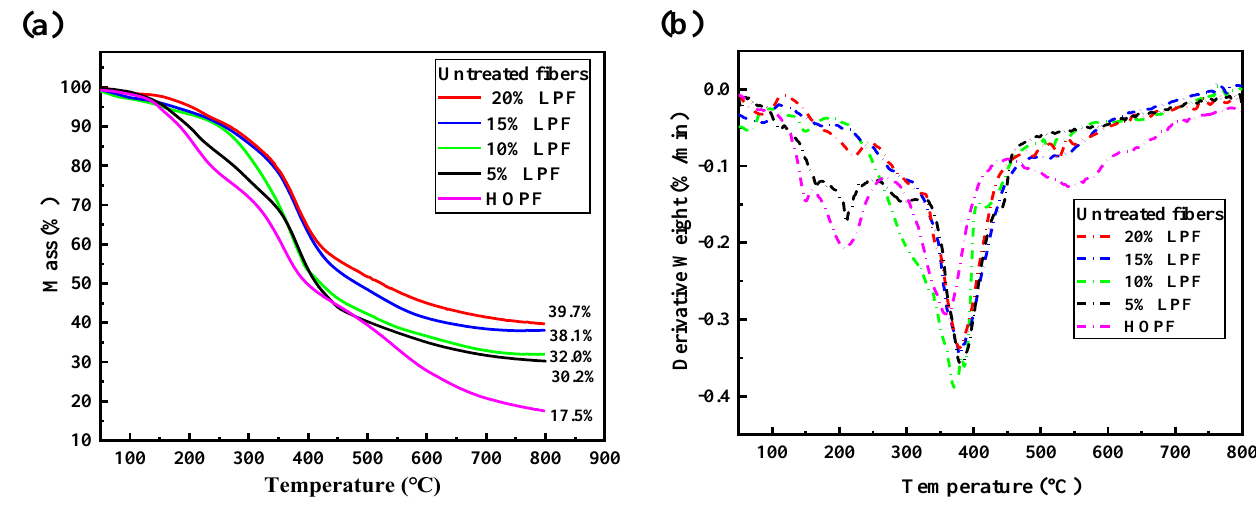
Figure 4. ( a ) TG curves of LPFs and HOPF; ( b ) DTG curves of LPFs and HOPF. The TG–DTG thermograms of the cured fibers after coagulation-bath and high- temperature treatment are shown in Figure 5. The carbon yields of the cured LPFs were improved, with the carbon yield of the 20% LPF being the highest. In comparison with Figure 4, curing and high-temperature treatment largely eliminated the first-stage mass losses of the fibers and increased their main decomposition stage temperatures. The de- composition stages are not clear until 350 ◦ C, indicating that curing and high-temperature treatment improve the thermal stabilities of the fibers. Similarly, as shown in Figure 5a, lignin addition increases the thermal stabilities of the cured fibers, and the increase in lignin content is positively correlated with the thermal stability, which is consistent with the thermal stabilities of the uncured fibers. Lignin in this study did not undergo additional treatment; therefore, the aromatic structure of lignin was largely retained and the thermal properties in the resin system were improved. According to Figure 6c, the increase in unreactive lignin components within the resin affects the continuity of the resin, leading to a decrease in the tensile strength and elongation at break of the